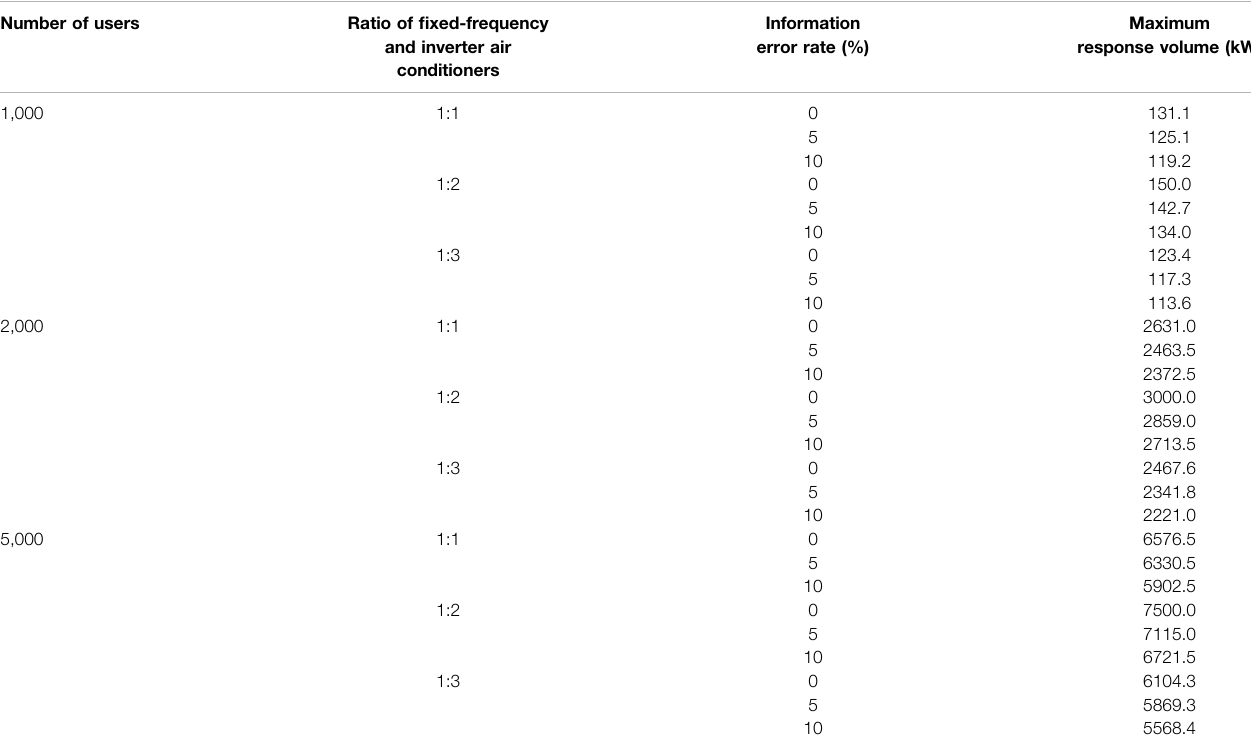
Information error rate (%)